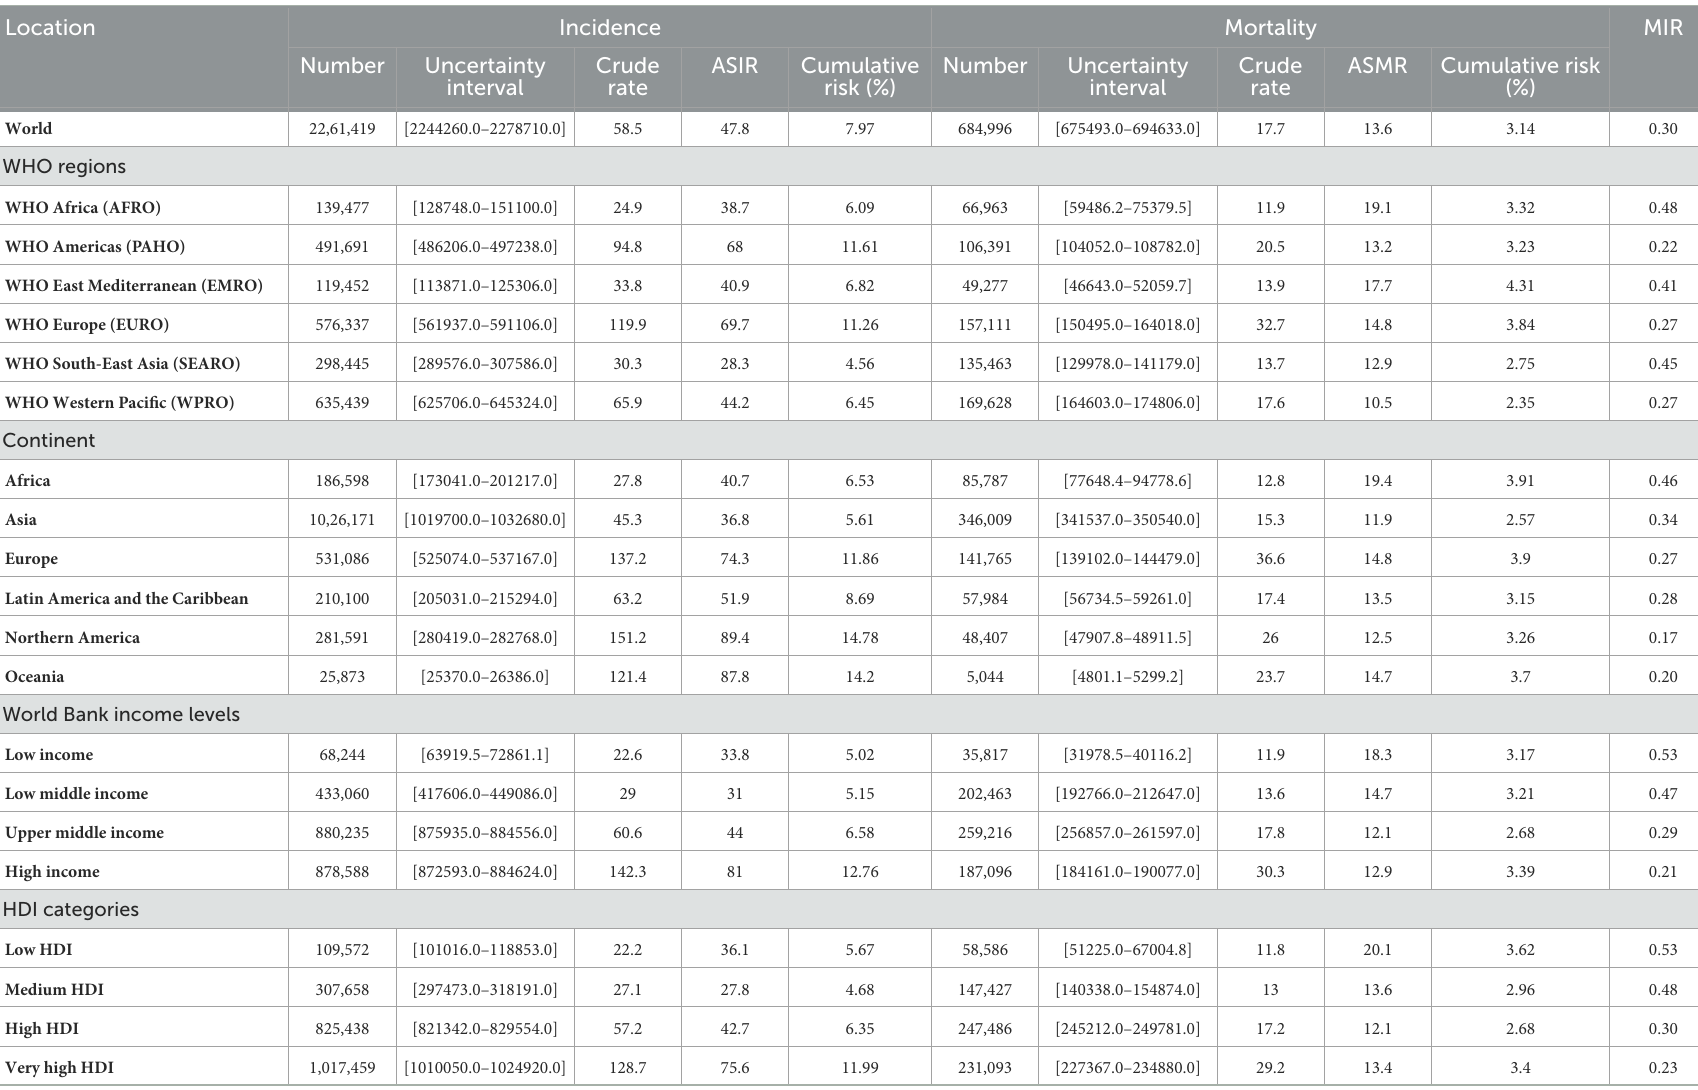
TABLE 1 Breast cancer (BC) incidence and mortality metrics in all-age number, crude rate, and age-standardized rates per 100,000 population, and an all-age cumulative risk for different geographic and socioeconomic categories.